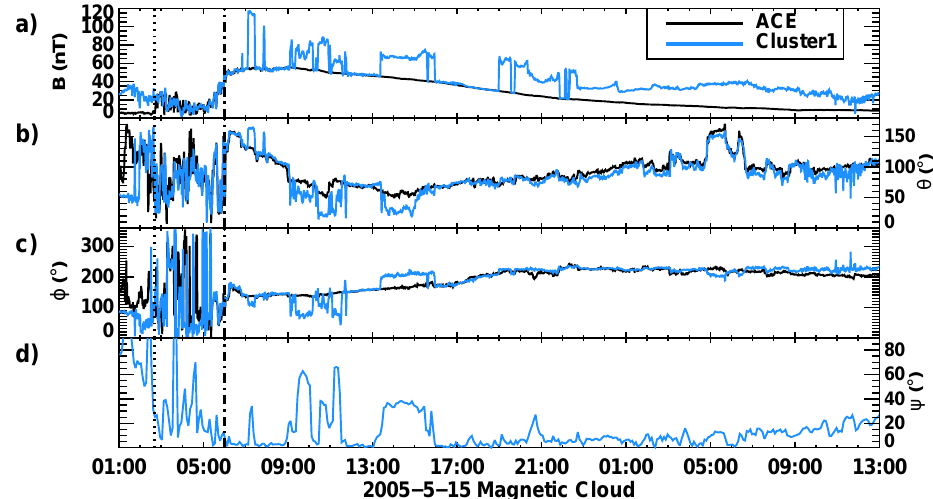
Figure 3. 15 May 2005 MC: observations from ACE (black) and Cluster (blue), in GSE coordinates. Vertical dashed line: beginning of the sheath of the MC. Vertical dotted dashed line: beginning of the MC. From top to bottom: magnetic field strength; θ ; ϕ ; and ψ , the angle between the magnetic field observed by Cluster and by ACE.